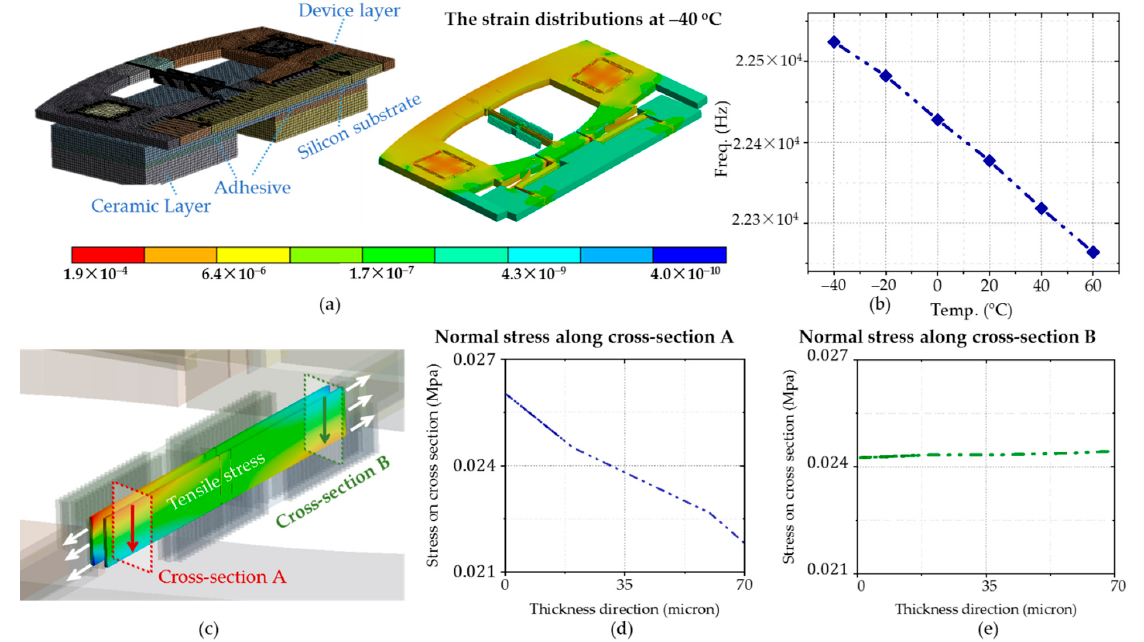
Figure 7. ( a ) The finite element model of the Resonant accelerometer and the train distributions under − 40 ◦ C with hard adhesive; ( b ) The relationship between temperature and symmetric motion resonate frequency; ( c ) The resonance beam exhibits tensile stress in operating temperature; ( d , e ) Normal stress along with cross-section A & B.